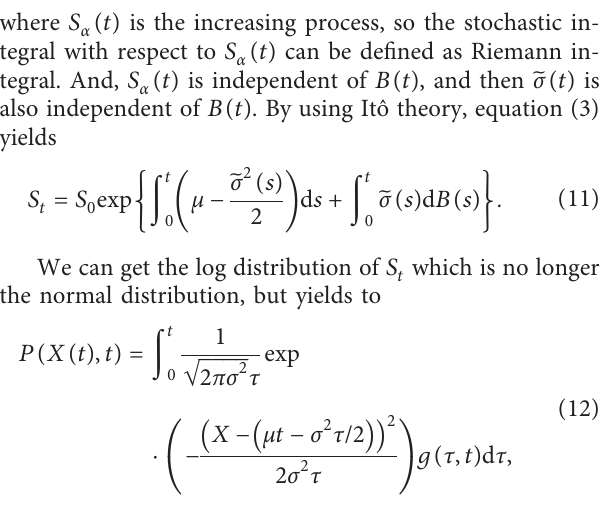
Figure 1: Comparison of trajectory of the standard Brownian motion B ( t ) (a) and the subordinated Brownian motion B ( S α � 0 .